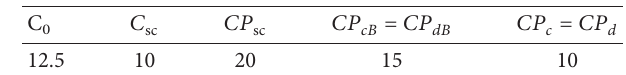
Table 2: Unit costs.